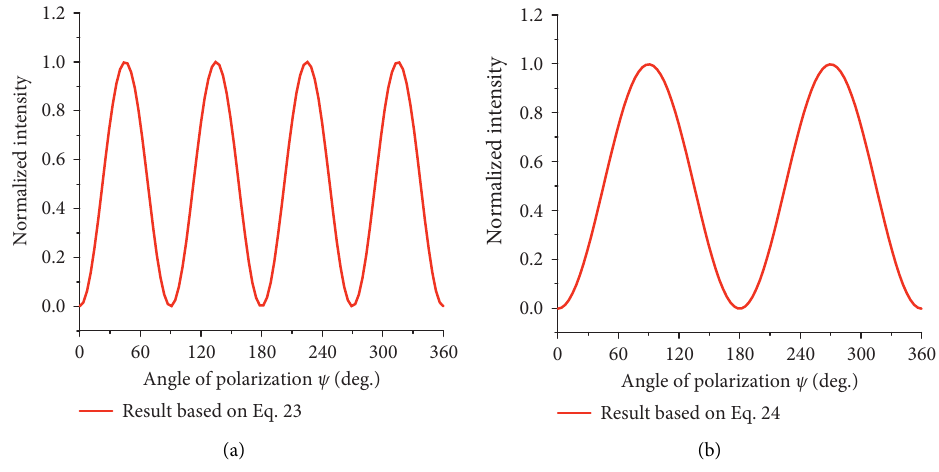
Figure 19: Raman intensity distribution under the oblique backscattering configuration ( β in the (a) HH case and (b) HV case considering and not considering the influence of the refractive index and depolarization.